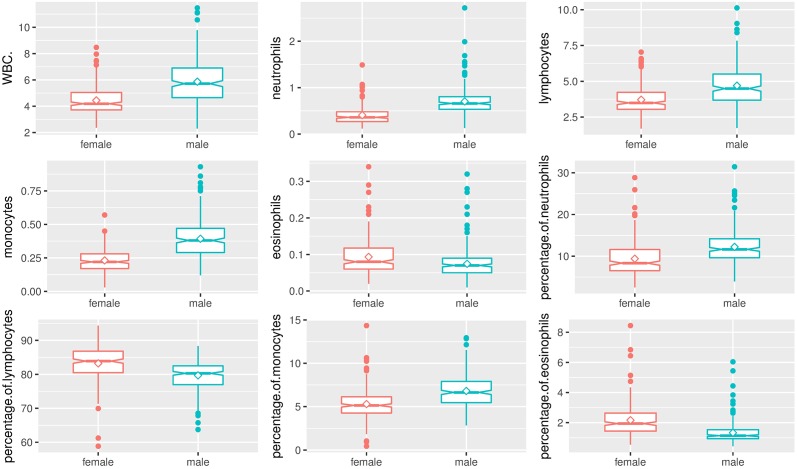
Box and whisker plots show differences in analyte levels of male and female Sprague-Dawley rats on WBC parameters.Data were depicted as box plots that indicated the median, 25th and 75th percentiles (box), mean (◇), and 1.5 times of interquartile (whiskers). Male rats were indicated by a green line, and female rats were indicated by a red line.